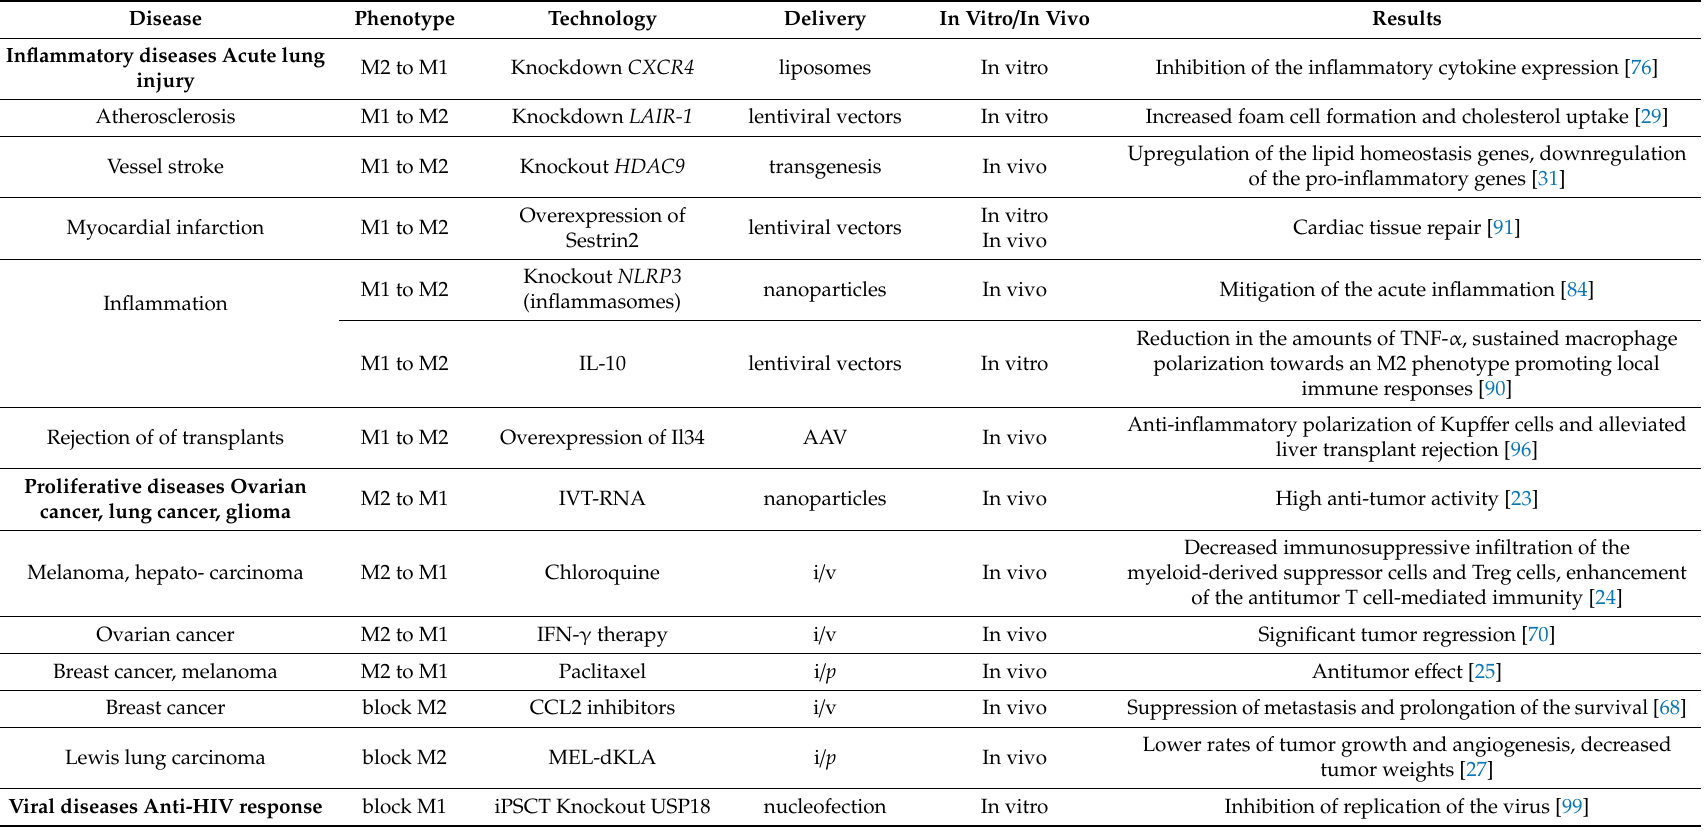
Table 3. The main applications of macrophage reprogramming in vitro and in